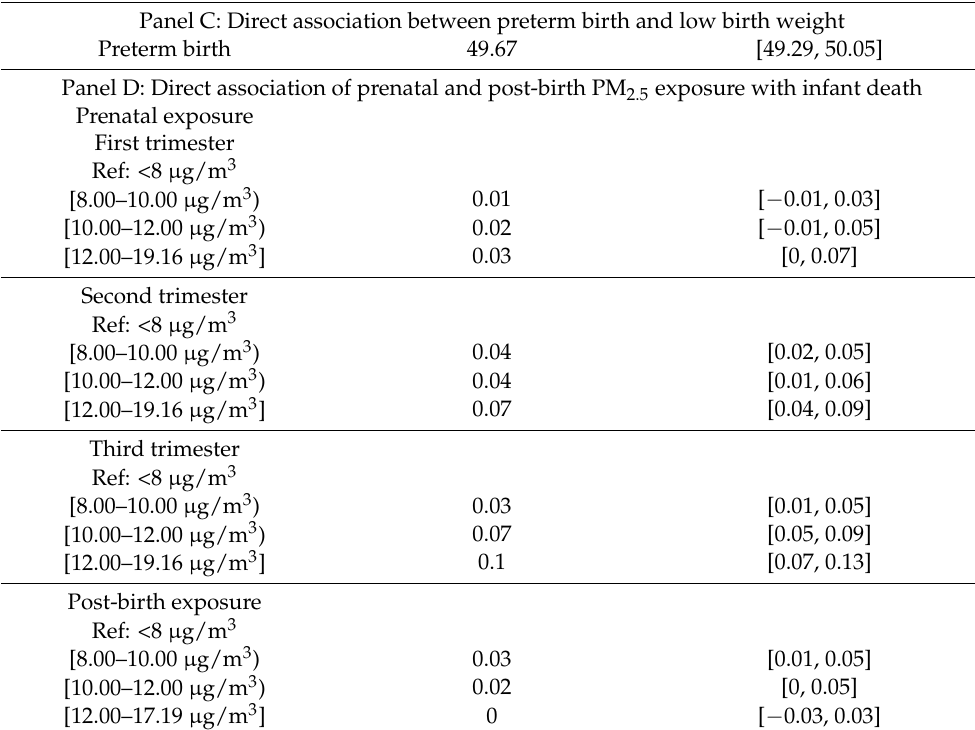
Panel E: Direct association of preterm birth and low birth weight with infant